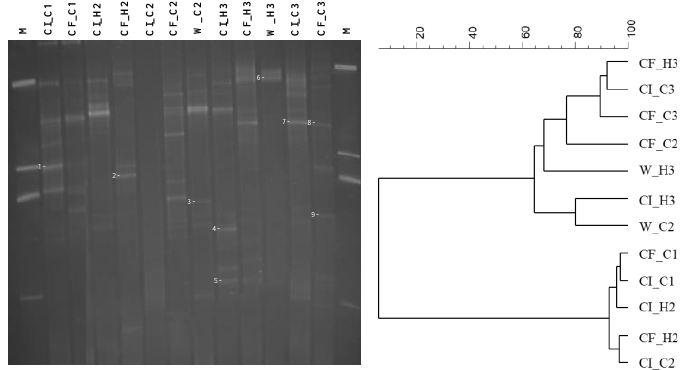
Figure 2. Cluster analysis generated by the 18S rRNA DGGE patterns of arbuscular mycorrhizal fungi (AMF) communities colonizing roots of C. indica (CI), C. flaccida (CF), and W. borbonica (W) inhabiting a constructed wetland during cold (C) and hot (H) seasons across three consecutive years (1, 2, and 3). The dendrogram was created using the UPGMA method (group average method) and based on the Pearson correlation coefficient. A commercial reference marker (M) was included for internal normalization of the gel. Excised bands are marked in gel with numbers (1 – 9).